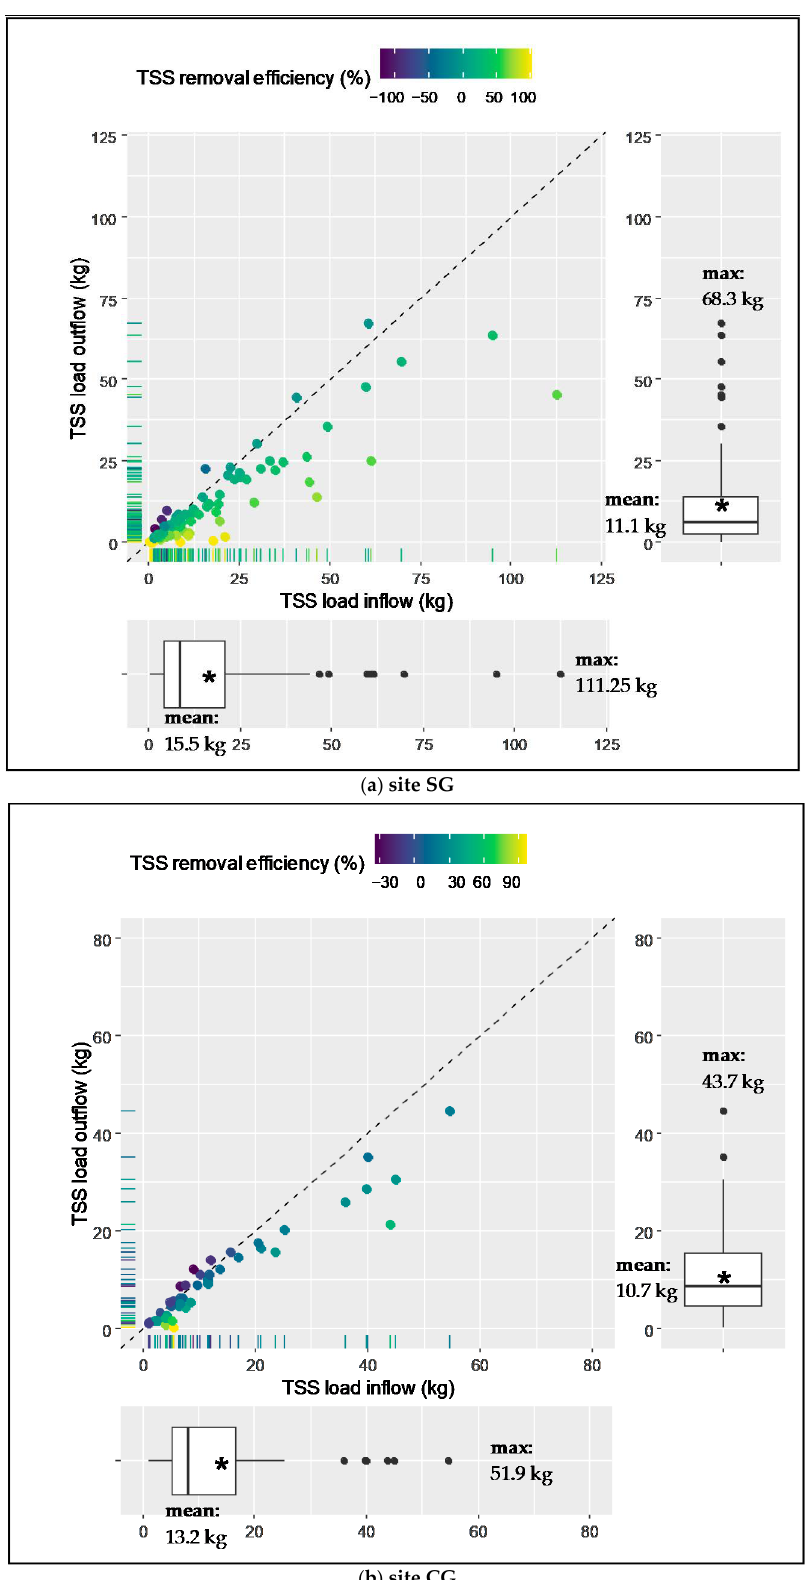
Figure 5. Event-specific TSS loads of in- and outflows with event-specific TSS removal efficiency at the sites SG ( a ) and CG ( b ); “*“ = mean values in boxplots; figure modified from [46]. Outliers are indicated as black dots.